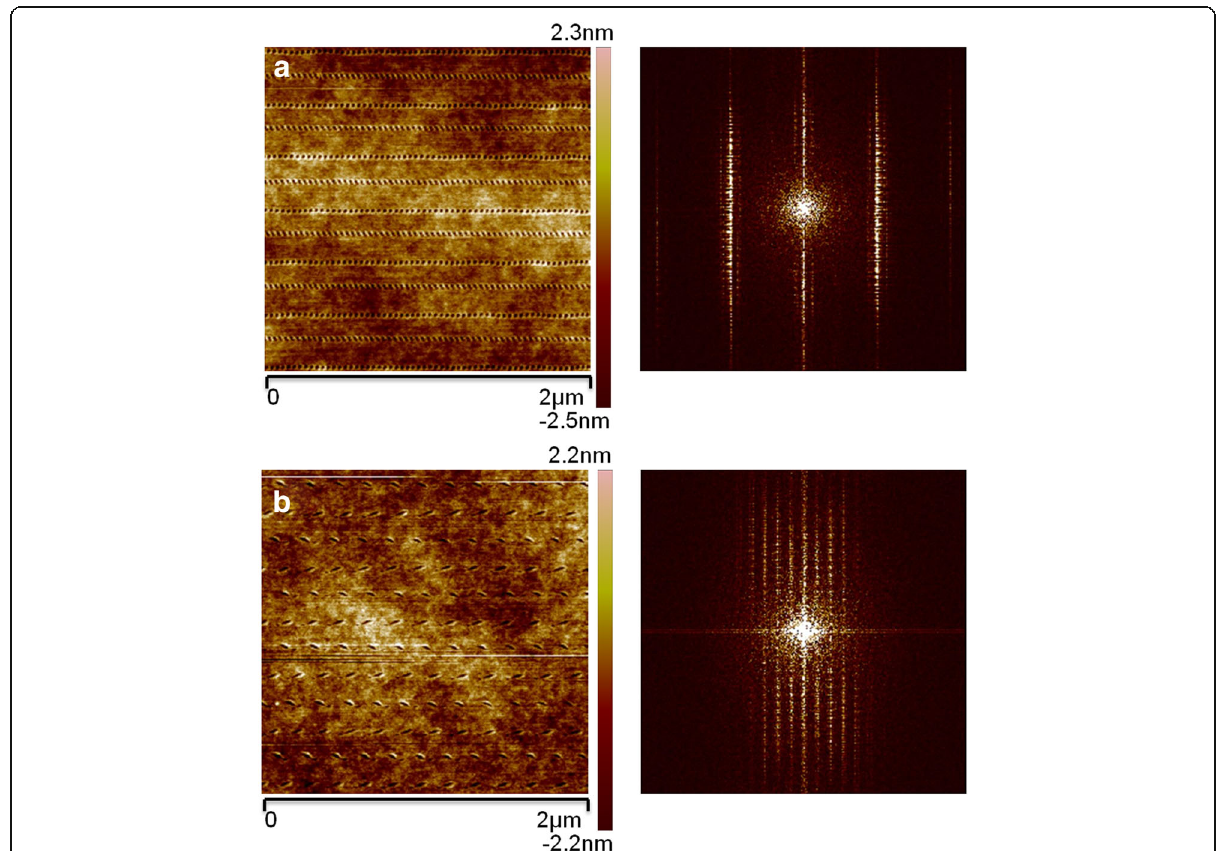
Fig. 8 AFM image of pit arrary with a dimension of 2 μ m and FFT image of the morphology. The scratching velocities are a 200 μ m/s and b 900 μ